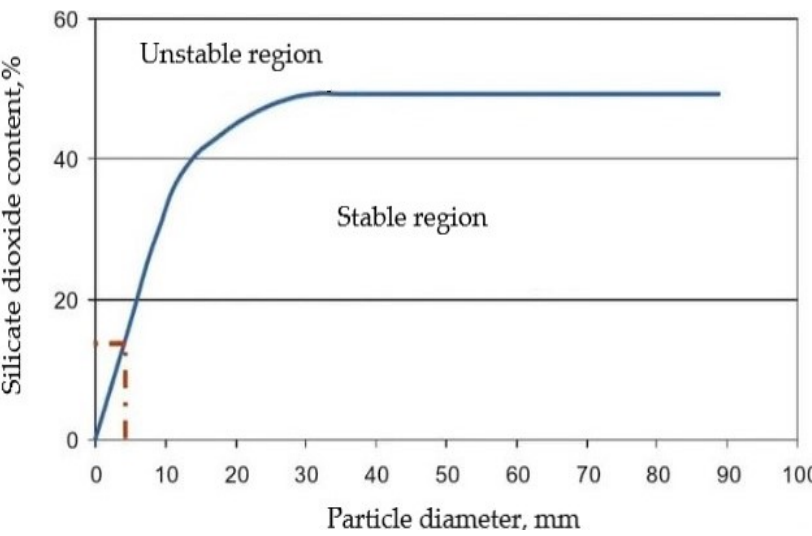
Figure 3. The dependence of the possible concentration of silica nanoparticles on the particle size. Reprinted with permission from ref. [9]. Copyright 2018 Egypt. J. Pet.